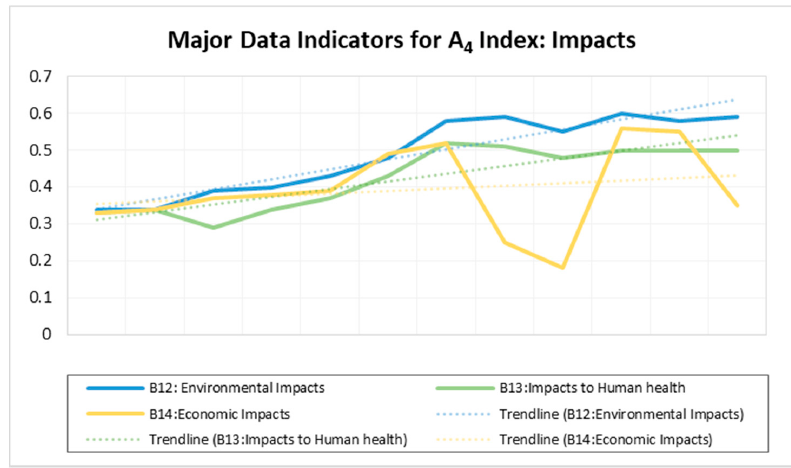
Figure 5. Major Data Indicators for A 4 Index: Impact.